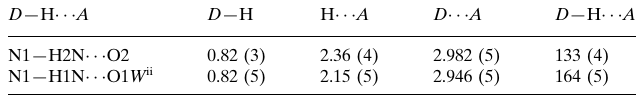
Hydrogen-bond geometry (A˚ , (cid:4)